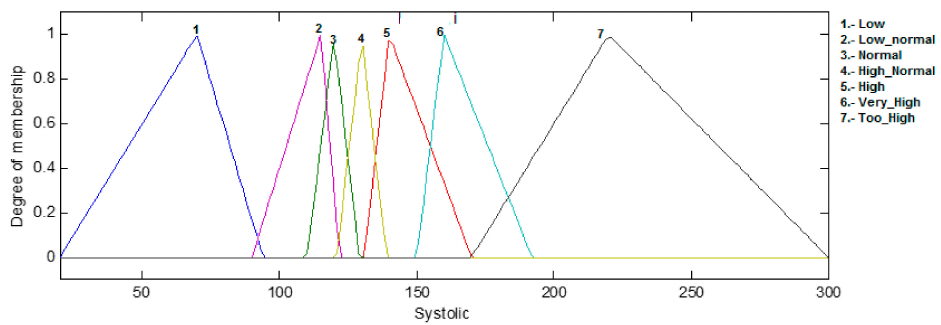
Figure 12. Systolic input for the fuzzy logic classifier 3.